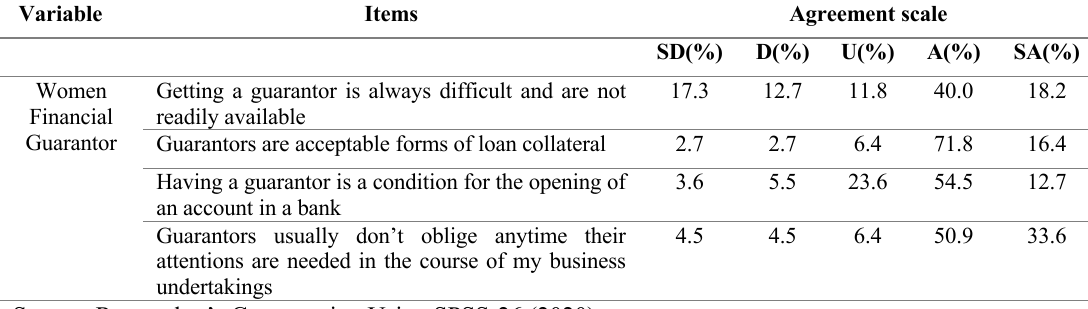
Table 3: Responses on Women Financial Guarantor